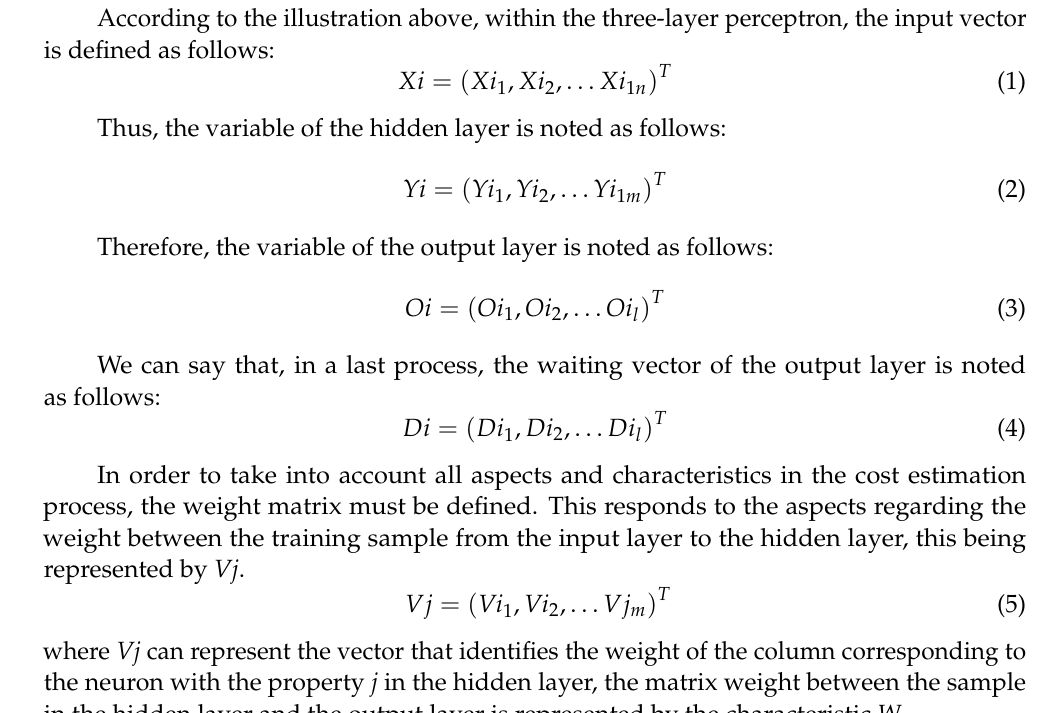
Figure 2. Illustration of the back-propagation neural network model in estimation process.